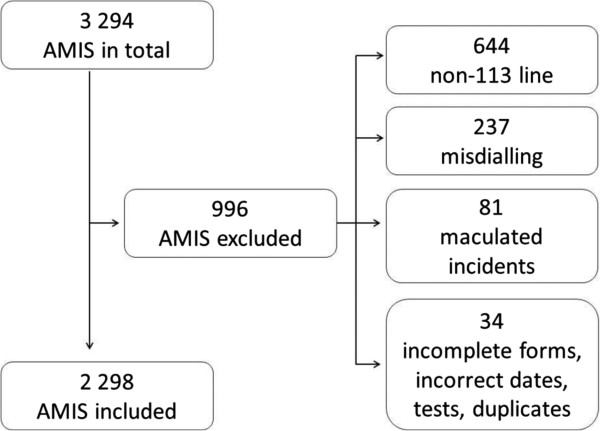
Excluded AMIS forms.